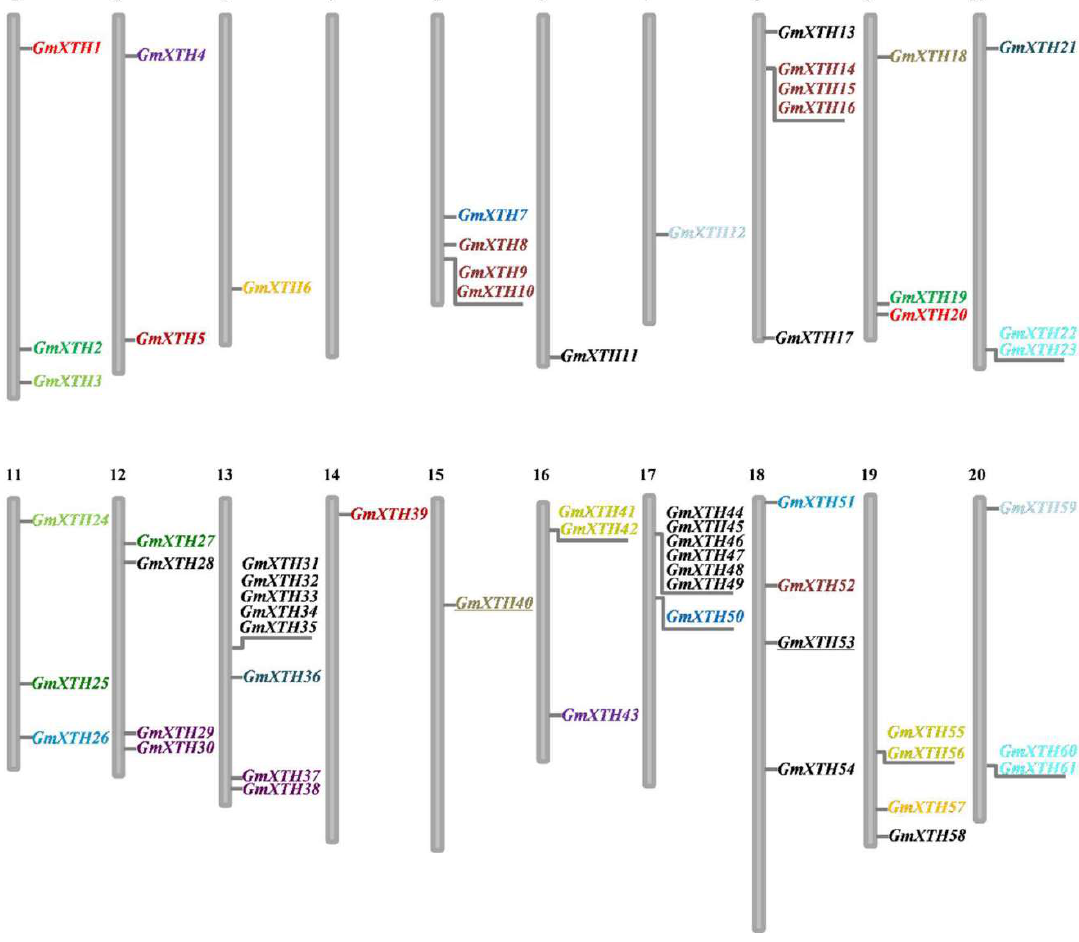
Figure 2. Chromosomal location of 61 GmXTH genes along soybean’s 20 chromosomes. Physical map showed the distribution of the Glycine max XTH genes along the 20 chromosomes with colors indicating duplicated gene pairs. The chromosome number is indicated at the bottom.